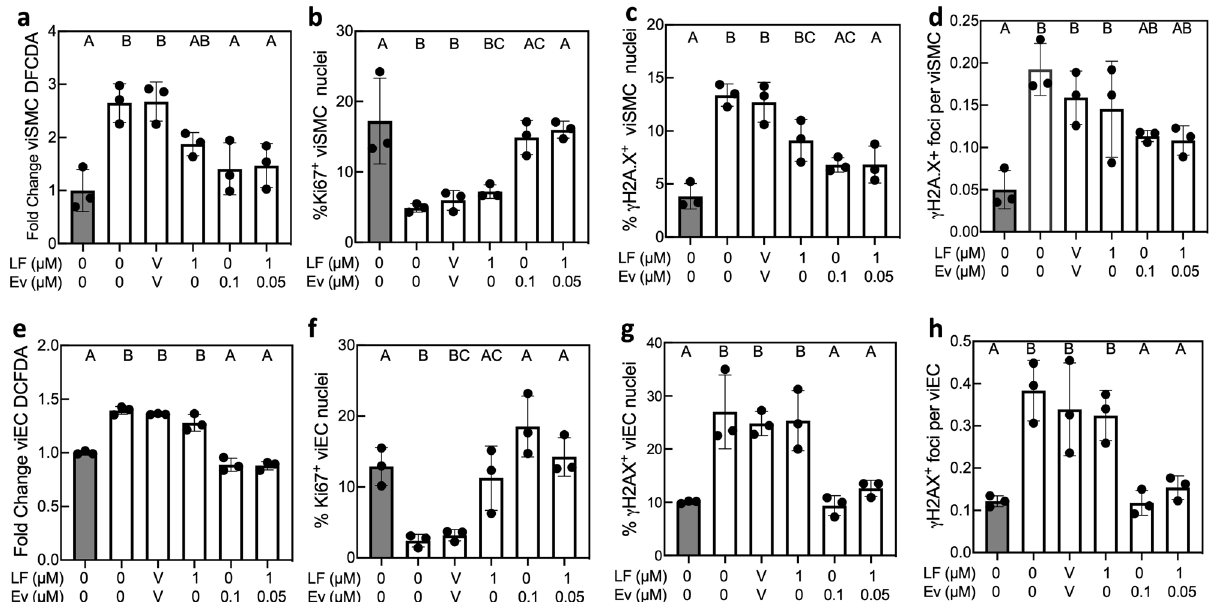
Figure 2. Everolimus reduces ROS levels, increases proliferation, and decreases DNA damage in HGPS 167 CL2 viSMCs and viECs. Healthy viSMCs ( a – d ) and viECs ( e – h ) and HGPS 167 CL2 viSMCs and viECs were treated with different combinations of Lonafarnib (LF) and Everolimus (Ev). ‘V’ indicates DMSO vehicle control. viECs and viSMCs from healthy donors are shown as gray bars and HGPS viECs and viSMCs are shown as white bars. Fold change of DCFDA mean fluorescence intensity compared with healthy in viSMCs ( a ) and viECs ( e ). Percent positive Ki67 nuclei in viSMCs ( b ) and viECs ( f ). Percent nuclei with ɣ H2A.X foci in viSMCs ( c ) and viECs ( g ). Number of ɣ H2A.X foci per total cells in viSMCs ( d ) and viECs ( h ). Data presented as mean ± SD. N = 3 experiments per group. Groups connected by the same letter are not significantly different from each other (p > 0.05). Groups labeled with different letters are significantly different from each other (p < 0.05). Exact p-values for significant differences are provided in Table